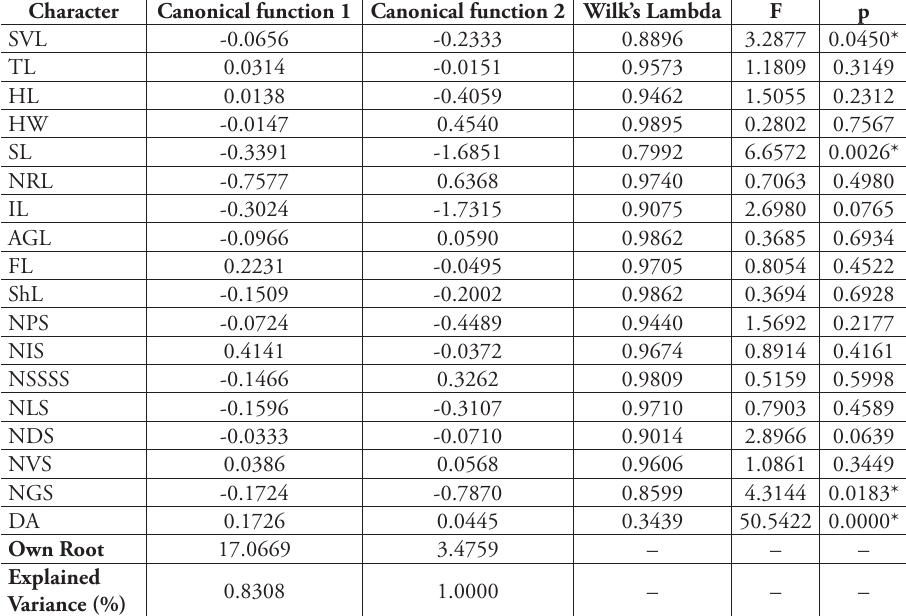
Table 2. The Own Root and Explained Variance of canonical functions 1 and 2, and results from Wilks’ Lambda tests from GDA of morphological data for males. Only statistically significant morphological variables according to Wilks’s Lambda test are presented. * p < 0.05.